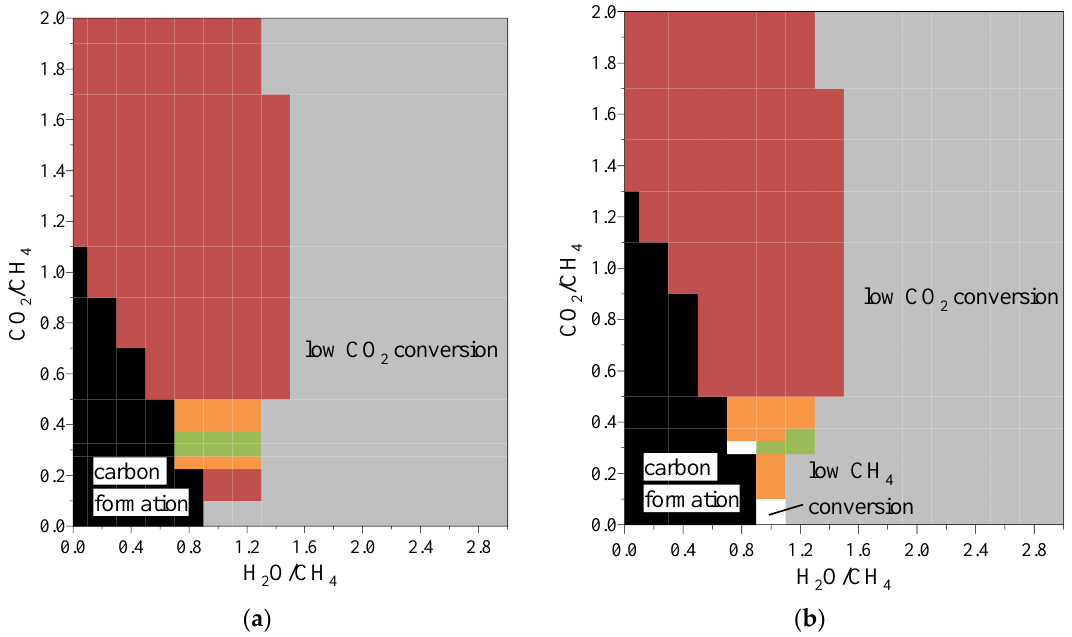
Figure 1. Exemplary color maps for M in dependence on H 2 O/CH 4 and H 2 O/CO 2 ratio. Reformer